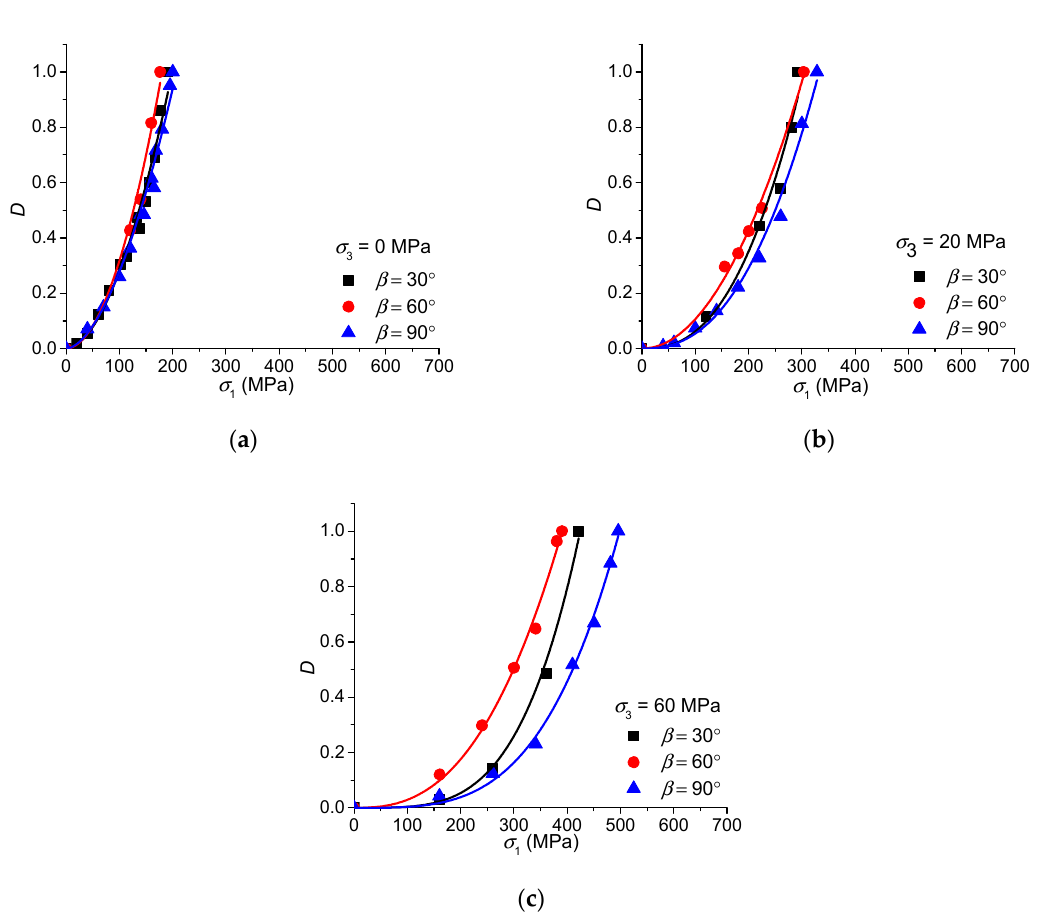
Figure 13. Evolution of damage variable with the increase of axial stress for the shale samples with different oriented weak planes under various confining pressures (( a ) σ 3 = 0 MPa, ( b ) σ 3 = 20 MPa, and ( c ) σ 3 = 60